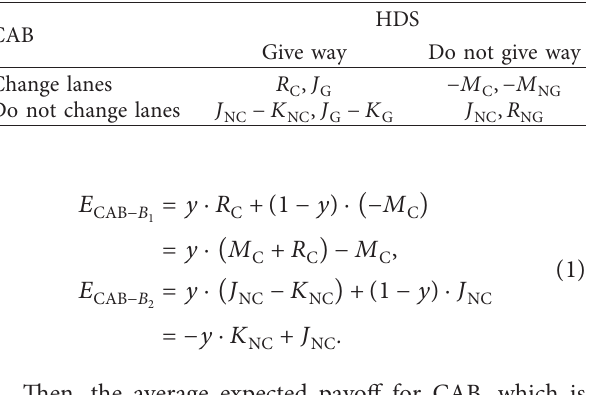
Table 2: Payoff matrix for CAB and